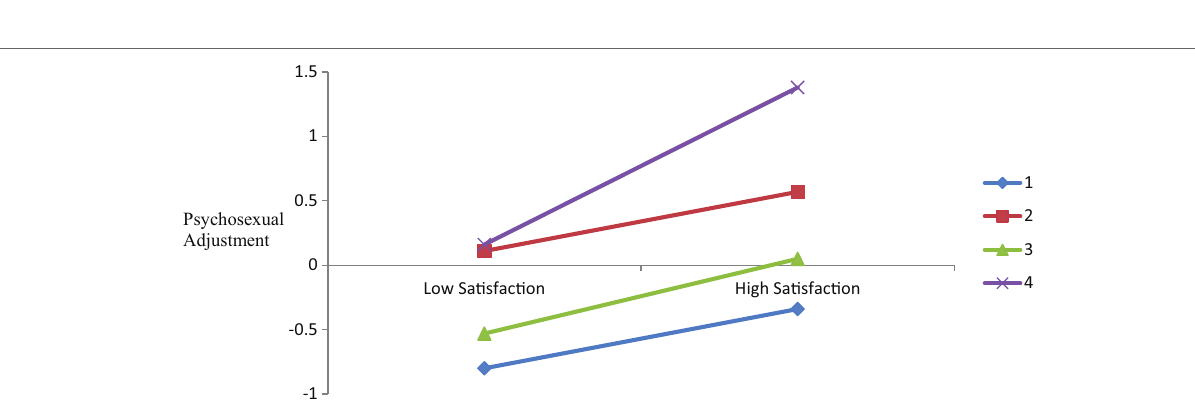
FIGURE 2 | Z scores for each profile ( n = 1,075). Note: 1, self-adjustment, 2, social adjustment, 3, sexual control, 4, psychosexual adjustment, psychosexual adjustment is the sum of self-adjustment, social adjustment, and sexual control.